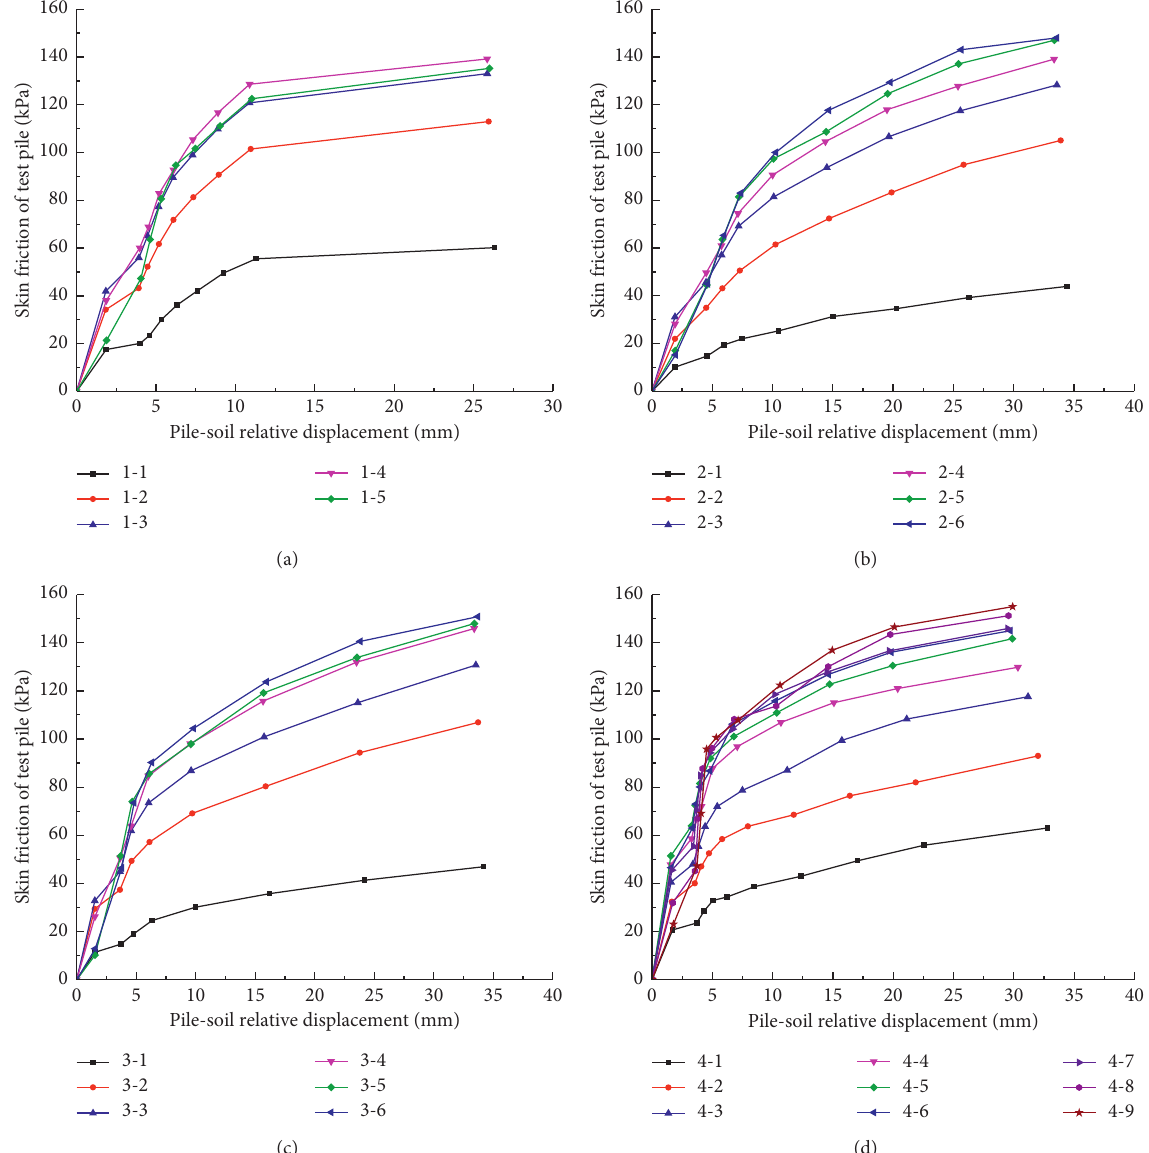
Figure 13: Distribution curves of shaft skin resistances versus relative displacements. (a) No. 1 pile. (b) No. 2 pile. (c) No. 3 pile. (d) No. 4